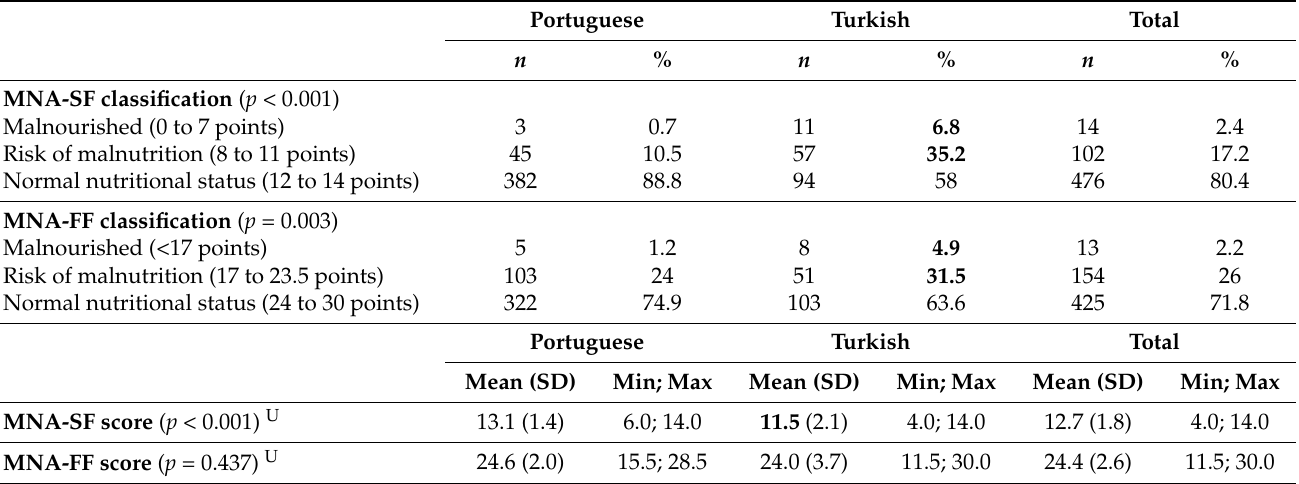
Table 3. Comparisons between Portuguese and Turkish older adults regarding nutritional status. Portuguese Turkish